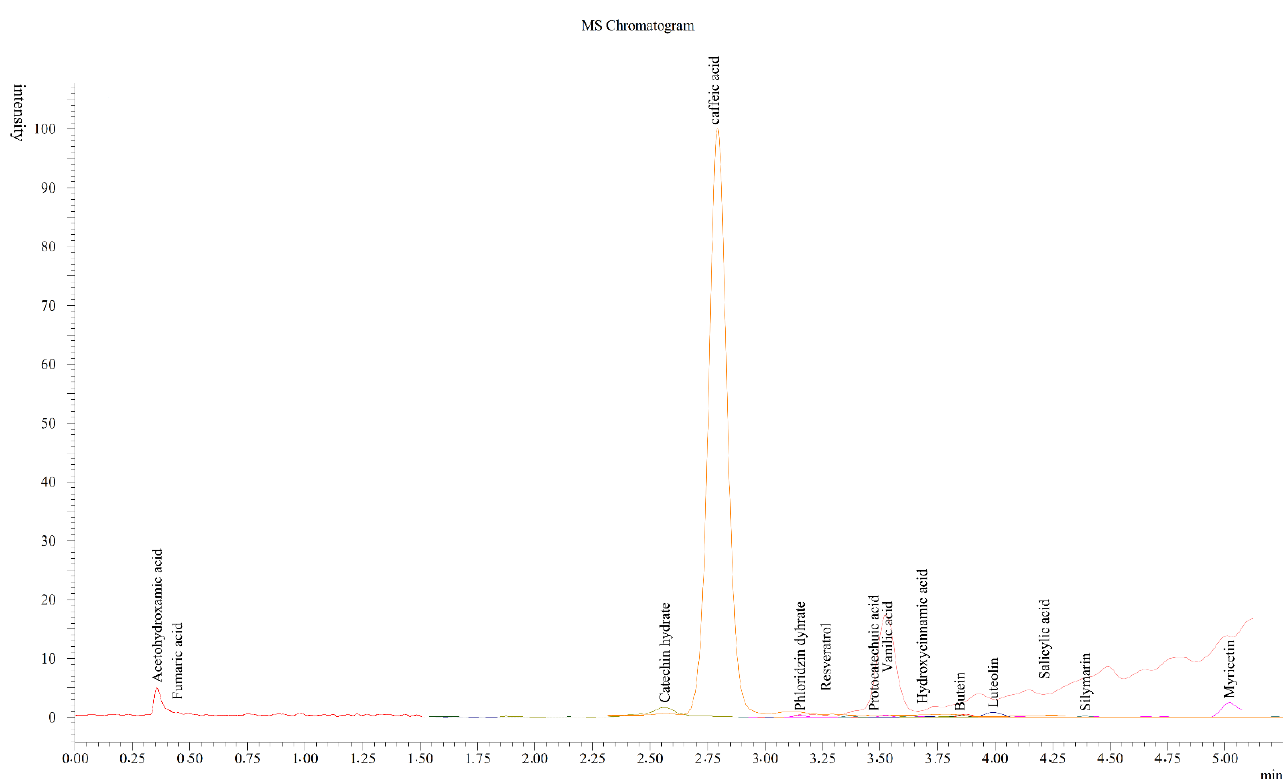
Figure 1. The chromatogram of the phenolic acids in CT extract obtained by the LC-MS/MS method. The phenolic compound profiles of CT were determined compared to standard com- pounds. As seen in Table 1, the major compound of CT was detected as vanillic acid and followed by caffeic, fumaric, and acetohydroxamic acids, butein, myricetin, resver- atrol, catechin hydrate, and 4-hydroxybenzoic acid, respectively. The determined com- pounds consisted of flavonoid glycosides, phenolics, phenolic acids, and their deriva- tives. Khider et al. [38] reported that vanillic acid, p -coumaric acid, protocatechuic acid, anthocyanins, derivatives of hesperidin and quercetin, and p -coumaric and ferulic acid were found in corn silk. Kapcum et al. [9] detected vanillic, caffeic, ferulic, p -coumaric, p -hydroxybenzoic, and sinapic acids, as well as kaempferol and quercetin, in different parts of purple waxy corn. Additionally, del Pozo-Insfran et al. [39] stated that the polyphenolic compound profiles and amounts might be different depending on their properties, origin, and growing